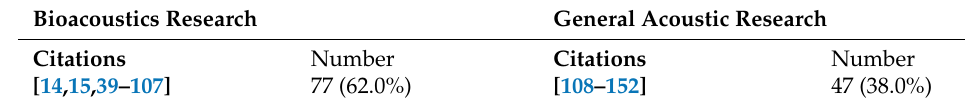
Table 3. Literature exclusion and inclusion criteria.